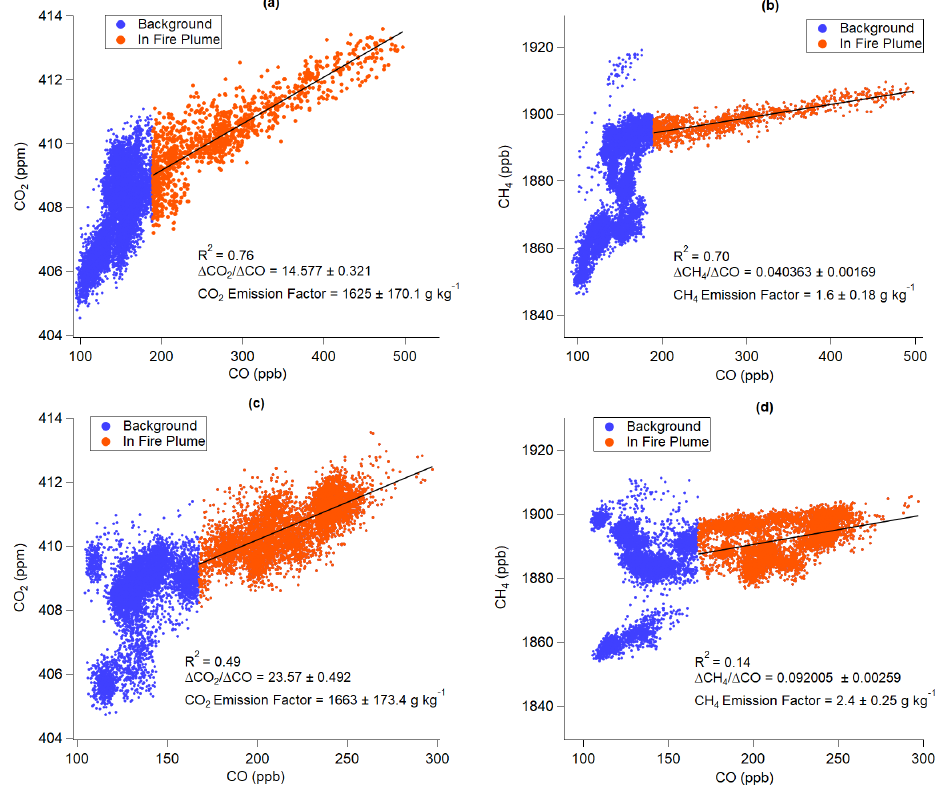
Figure 11. Linear regressions of in-plume (a) CH 4 and (b) CO 2 mixing ratio vs. in-plume CO mixing ratio for flight C006 and (c) CH 4 and (d) CO 2 mixing ratio vs. in-plume CO for flight C007. The linear regressions are calculated using the York regression method and are weighted towards CO and CH 4 / CO 2 measurement uncertainty (York et al., 2004). ERs obtained from the slope are also shown, as well as the calculated